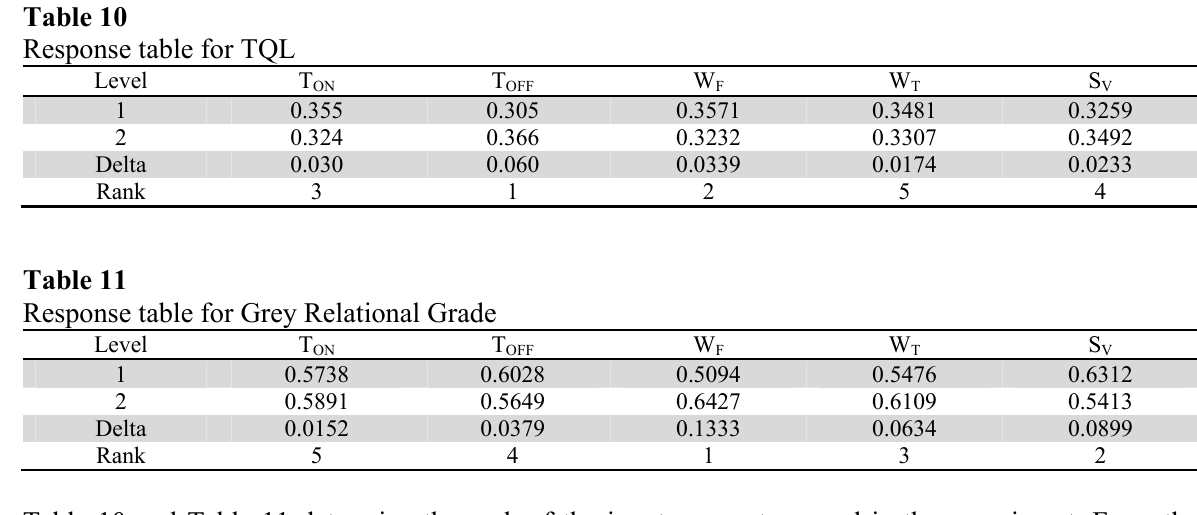
Table 10 and Table 11 determine the rank of the input parameters used in the experiment. From